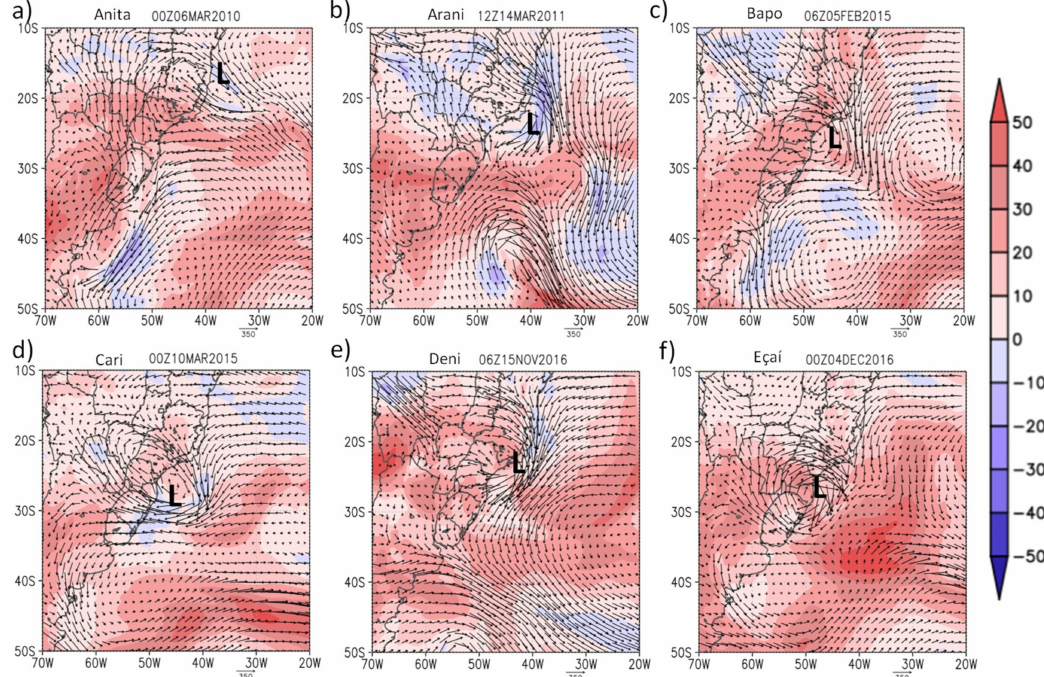
Figure 6. Vertical wind shear (m · s − 1 ) in the layer 200–850 hPa (200 minus 850 hPa; shaded) and the vertically integrated horizontal moisture flux (vectors in kg · m − 1 · s − 1 ; black lines) at the genesis of the six subtropical cyclones: ( a ) Anita, ( b ) Arani, ( c ) Bapo, ( d ) Cari, ( e ) Deni and ( f ) Eça í